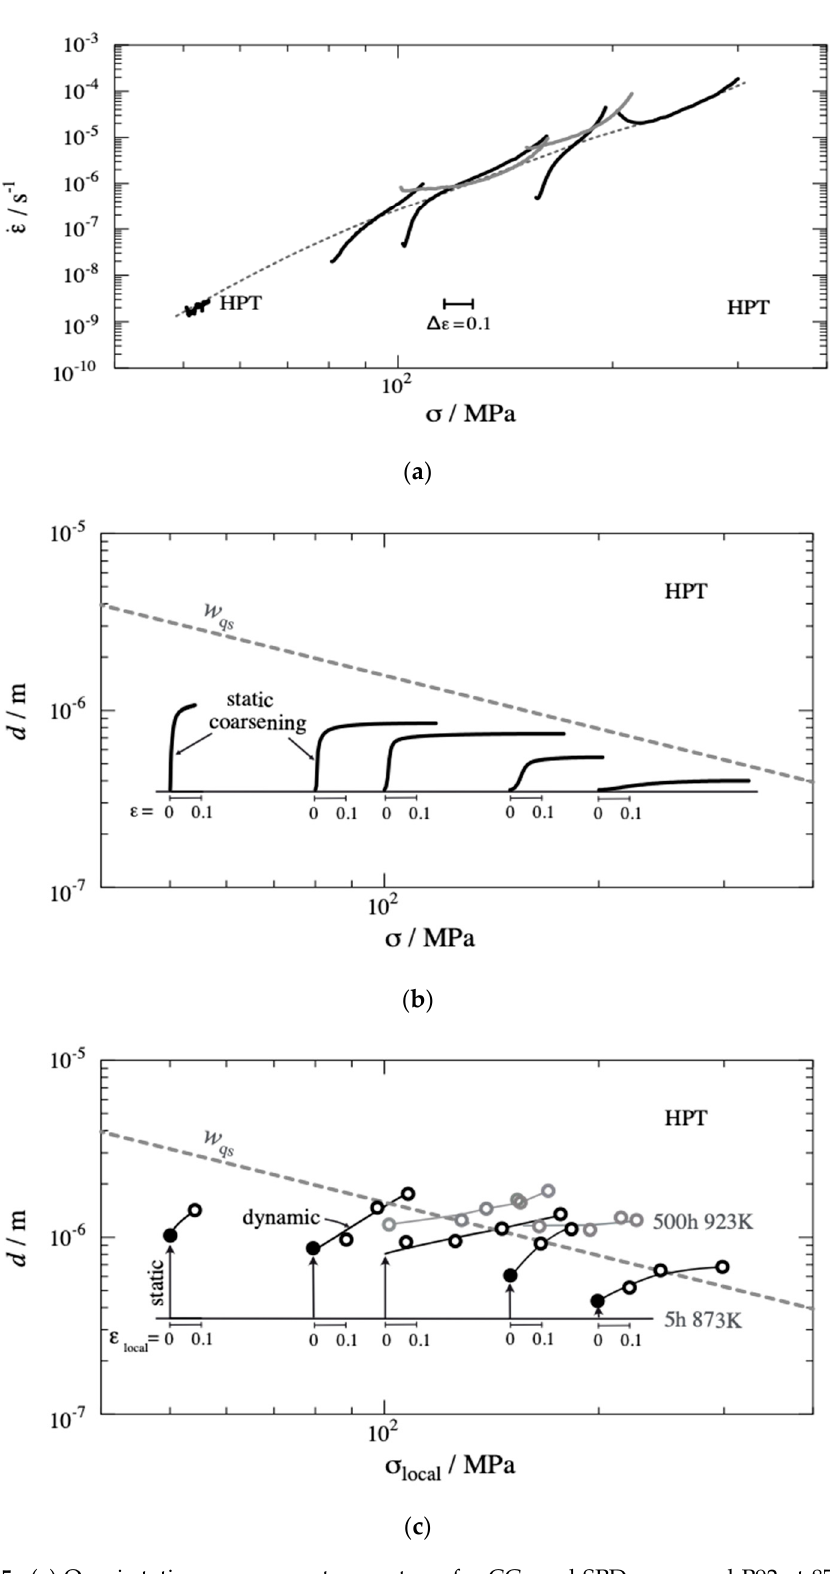
Figure 15. ( a ) Quasi-stationary creep rate vs. stress for CG- and SPD-processed P92 at 873 K and constant load; scale bar marks strain interval of 0.1. ( b ) Static coarsening of grains in tests ( a ) calculated according to Equation (2) (straight line in Figure 14). ( c ) Grain sizes at end of creep tests of ( a ) plotted versus local strain ε loc and local stress σ loc in di ff erent parts of specimens including grips; dashed line: quasi-stationary spacing value w qs = 10 bG / σ (shear modulus G = 63.5 GPa [25], Burgers vector b = 2.48 × 10 − 10 m [26]) of subgrain boundaries shown for comparison. Gray curves in ( a ) and gray symbols in ( c ) refer to specimens that had undergone long-term annealing at 923 K before